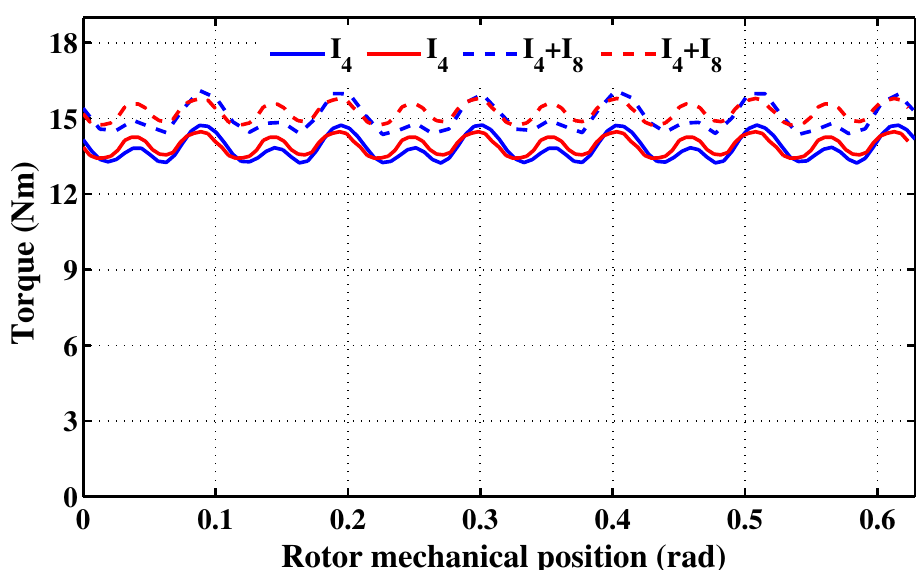
Figure 16. Torque-angle characteristics for a peak fundamental current of 3.6 A. Legend 1: (continu- ous line) armature current supply limited to the fundamental of rank 4; (interrupted line) armature current supply including both the fundamental of rank 4 and the harmonic of rank 8, such that the 8th harmonic initial phase is equal to 13 π /8 and the 8th harmonic amplitude to fundamental amplitude ratio is equal to 5%. Legend 2: (red) analytical results, (bleu) FEA results.